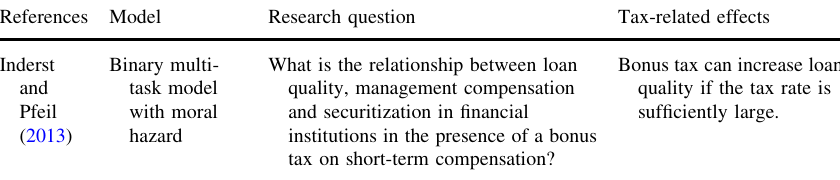
Table 9 Bonus taxes, investment decisions and capital